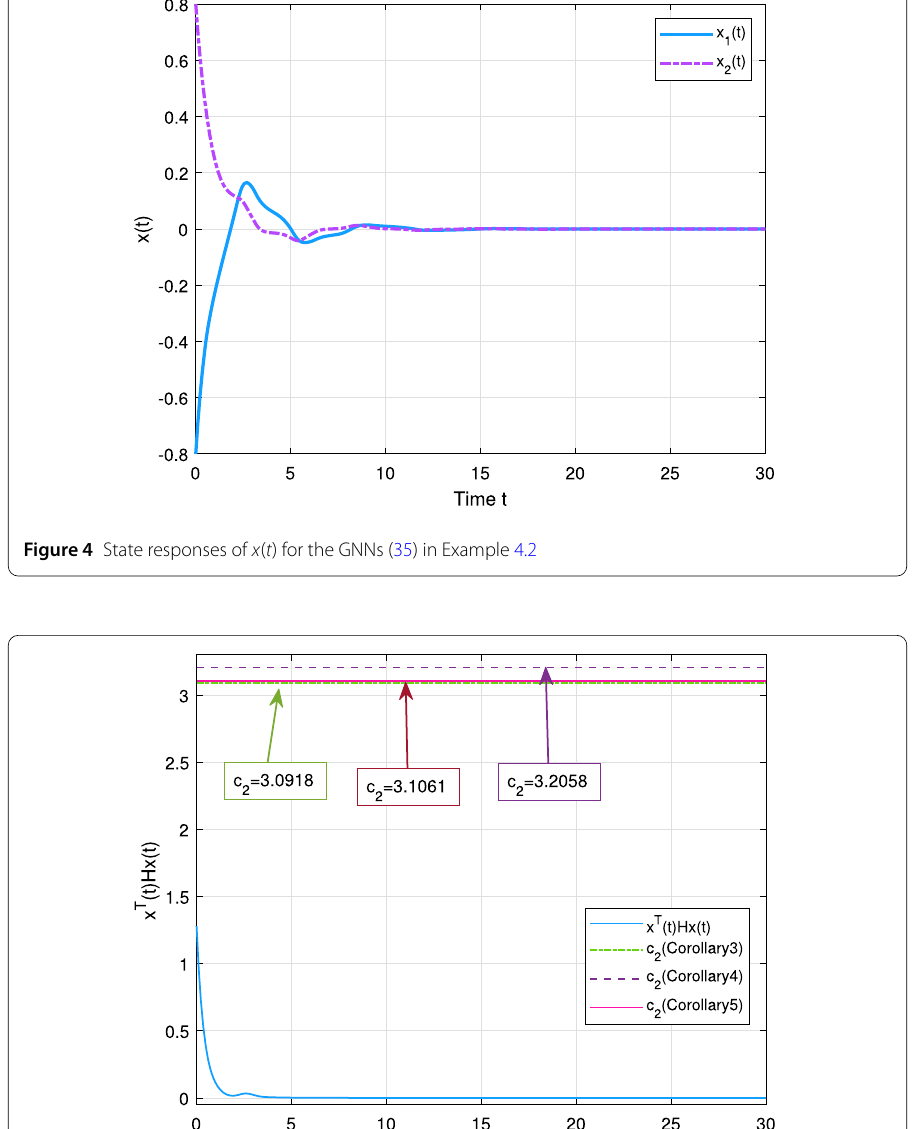
of interval time delay h Mm = 0.25 and different lower bounds h m =